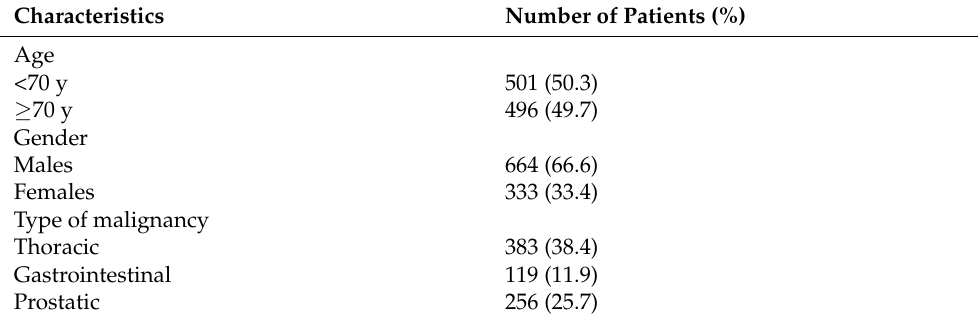
Figure 1. Flow chart of the recruiting in the vaccination campaign with BTN162b2 vaccine carried out at the Department of Oncology of San Luigi Gonzaga University Hospital and the enrollment in the descriptive analysis. PCR: Polymerase Chain Reaction; ECOG PS: Eastern Cooperative Oncology Group Performance Status; AE: Adverse Events. Table 1. Main characteristics of the study population. HT: hormone therapy; TT: targeted therapy; ChT: chemotherapy; ICIs: immune checkpoint